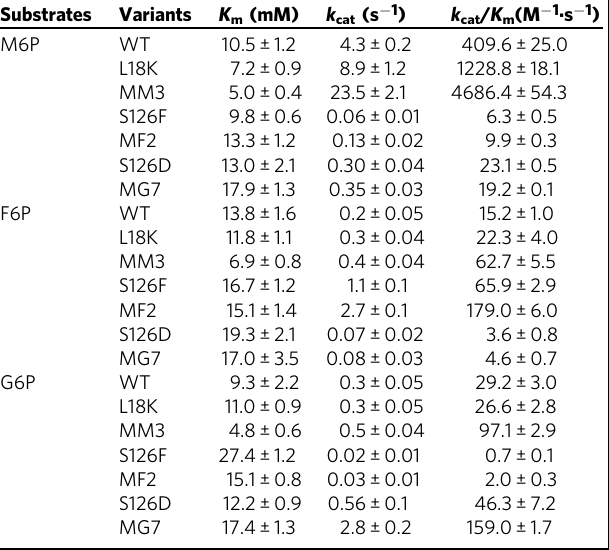
Table 1 The kinetic parameters for Ts38HM6PP and its variants with M6P, F6P, and